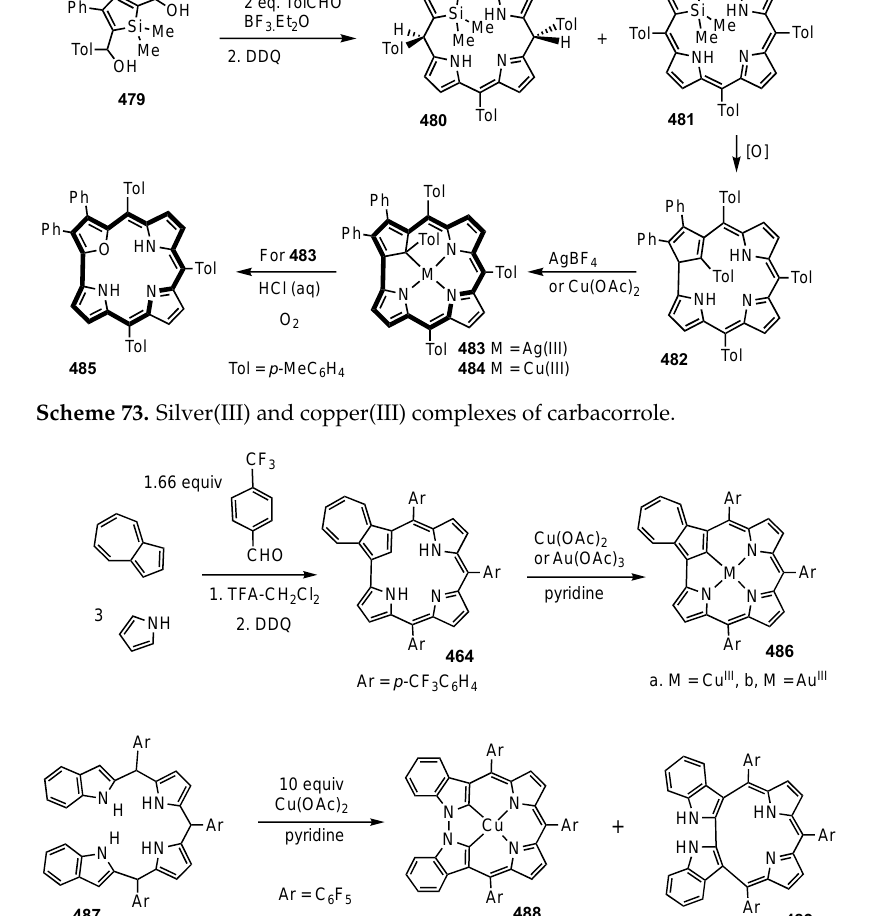
Scheme 74. Copper(III) and gold(III) complexes of carbacorrole analogues. Dicarbacorroles with a biphenyl unit or a phenanthrene moiety have been reported [306-308]. A bilane-like intermediate 490 incorporating a biphenyl unit was cyclized with pentafluorobenzaldehyde and BF 3 ·Et 2 O and, following oxidation with DDQ, dibenzicor- role 491 was obtained in 10% yield (Scheme 75) [306]. The X-ray crystal structure of 491